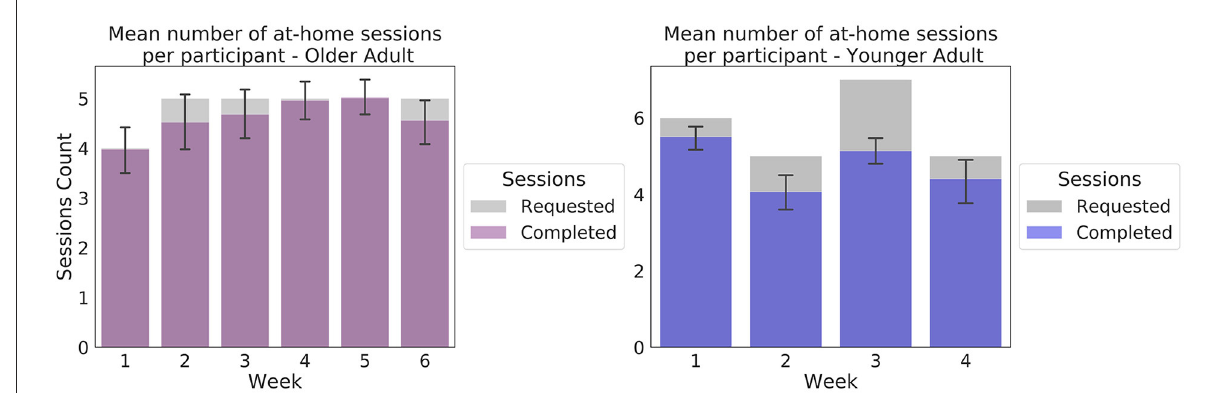
FIGURE4 Weekly at-home adherence to the experimental protocol. Data in purple correspond to the Older Adult study ( N correspond to the Younger Adult study ( N 30). Error bars represent 95% confidence intervals. The gray areas correspond to the number of = at-home sessions requested in the protocol. The number of sessions requested varied as per protocol, to accommodate scheduled in-lab sessions.